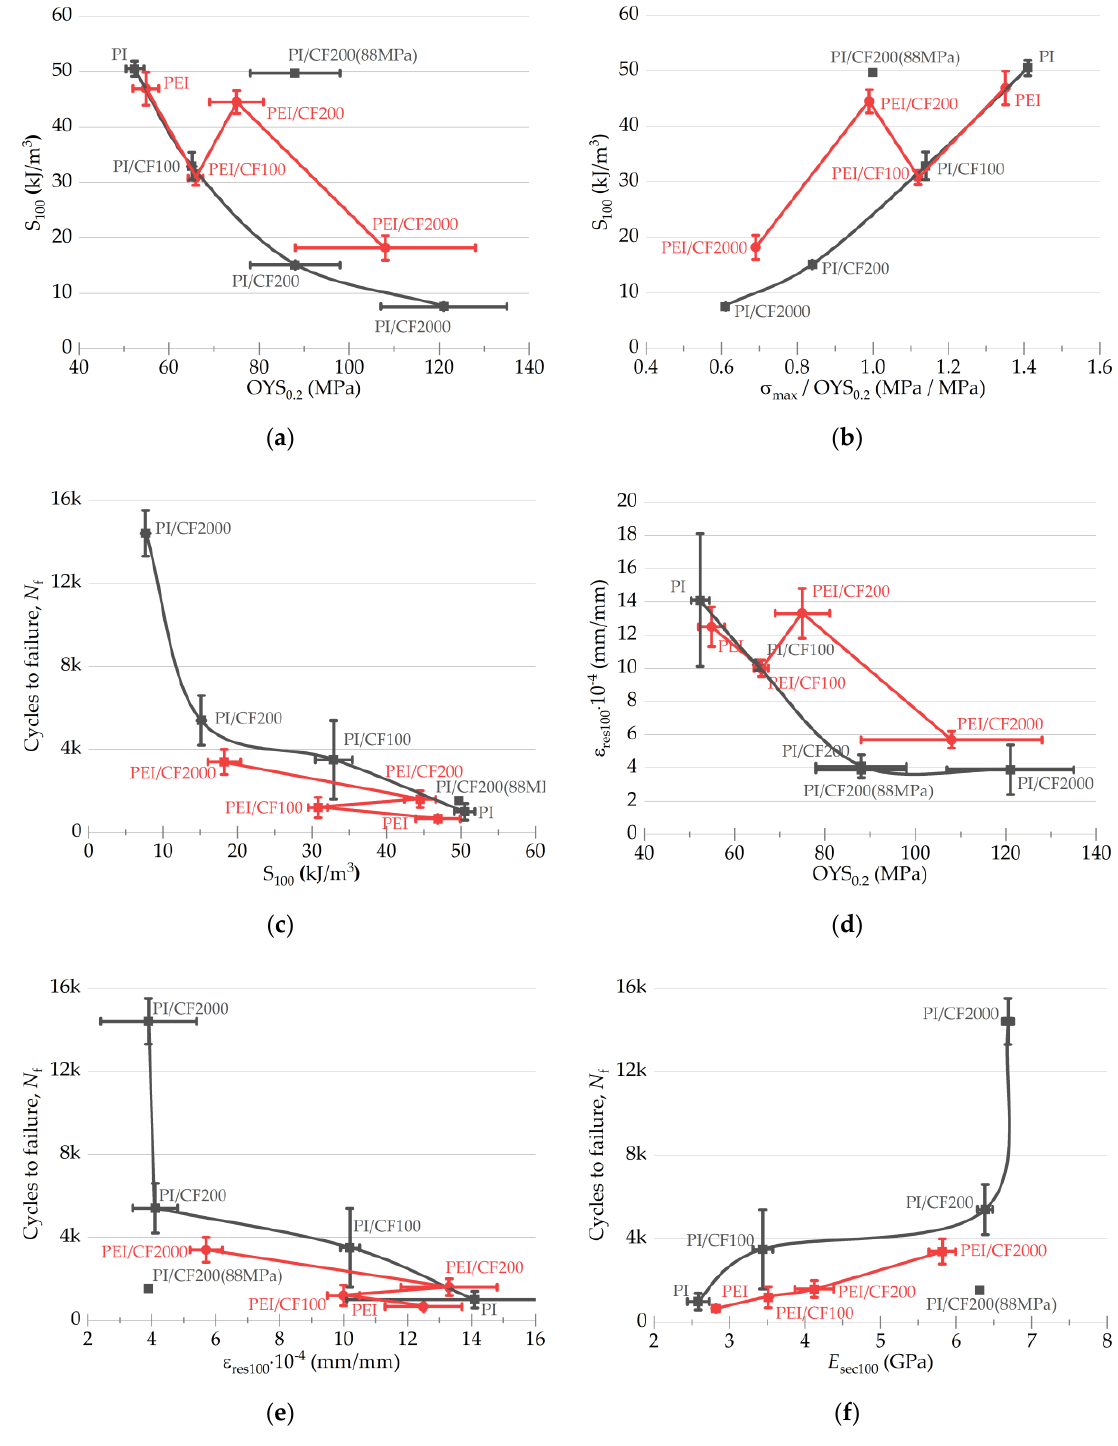
Figure 11. The relationships of both the elastic and plastic characteristics of the PI- and the PEI- based composites with the hysteresis loop areas S and the residual strain values (at 100 cycle): ( a )